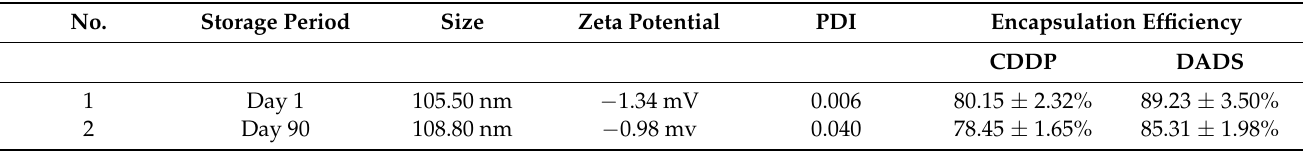
Figure 4. Colloidal stability of Lipo-CDDP/DADS after 90 days. ( a ) Average size and ( b ) zeta potential of Lipo-CDDP/DADS. The d.nm in ( a ) means diameter in nanometers, and the mV in ( b ) means millivolt. Table 3. Colloidal stability of